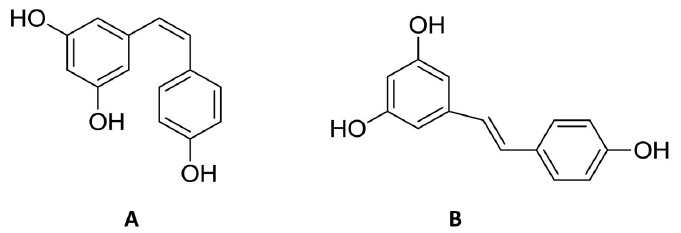
Figure 1. Chemical structure of cis ( A ) and trans ( B ) resveratrol.